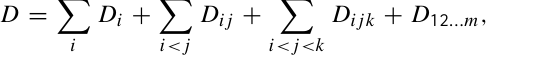
Table 4. Parameters of the VarKarst model, their descriptions, units and calibration ranges for the different study sites. Parameter Description Unit Recharge area Austria km 2 Recharge area Switzerland km 2 Recharge area Spain A Recharge area Palestine Recharge area Israel 1 Mean soil storage capacity Mean epikarst storage capacity a SE Soil/epikarst depth variability constant – K mean,E Epikarst mean storage constant a fsep Recharge separation variability constant – V crit,OF Critical volume to activate overflow spring Conduit storage constant Distribution of groundwater storage constants Geo SO Equilibrium concentration of SO 4 in matrix 4 a Geo Equilibrium concentration variability